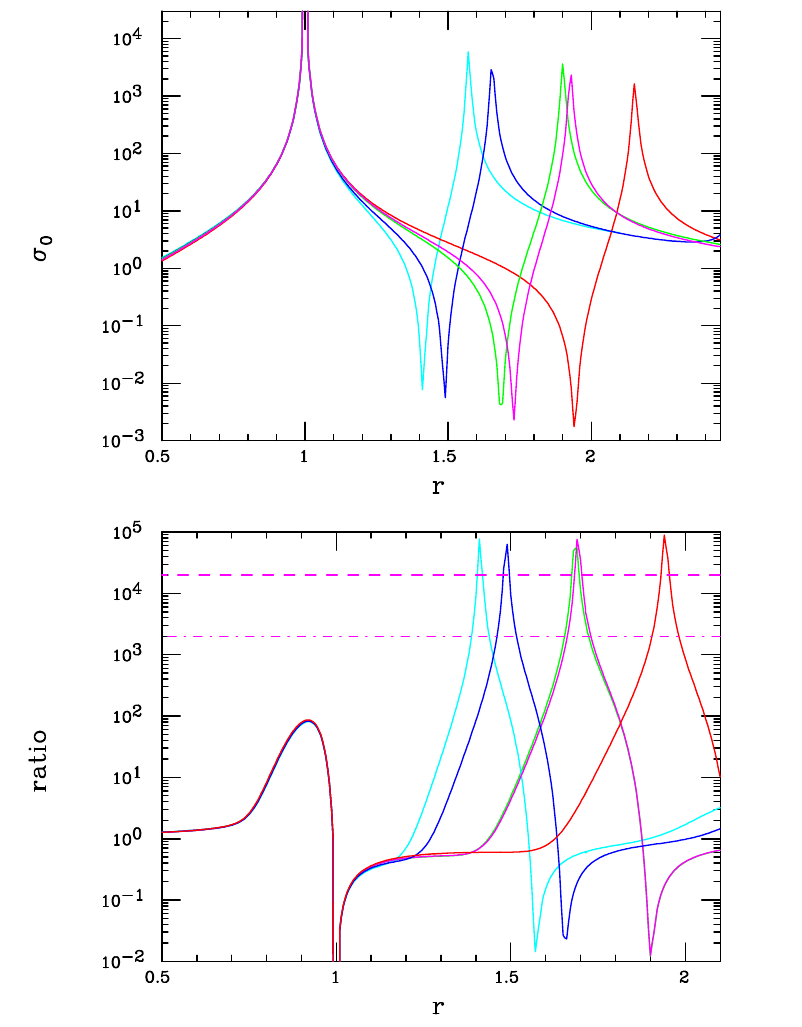
Figure 5 . Top) Scaled T = 0 DM annihilation cross section as a function of r = 2 m DM =m V the benchmark models BM1 (green), BM1’ (magenta), BM2 (blue), BM3 (red) and BM4 (cyan). (Bottom) Ratio of the freeze-out to T = 0 DM annihilation cross sections, K , as a function of r for the same BMs as in the top panel. The horizontal dashed (dash-dotted) lines are guides to the eye for K = 2 (cid:1) 10 4 (2 (cid:1) 10 3